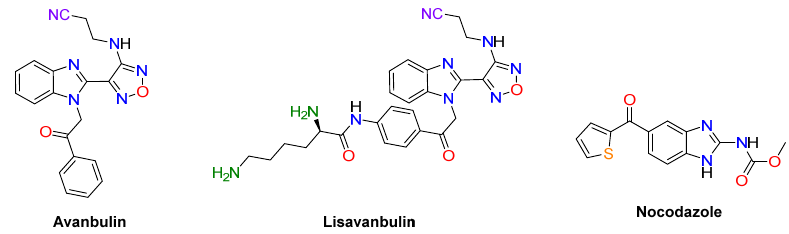
Figure 9. Selected examples of tubulin polymerization inhibitors.